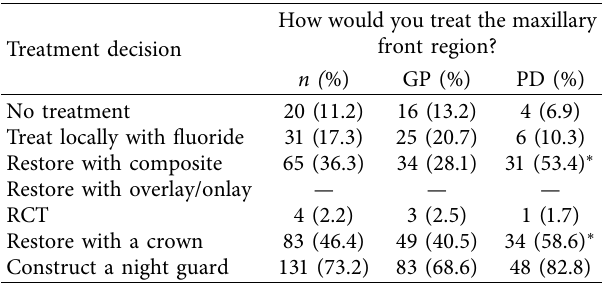
Table 5: The frequency of dentists’ treatment decisions and ( n ) the number of GPs and PDs responding to each treatment option on clinical case three.